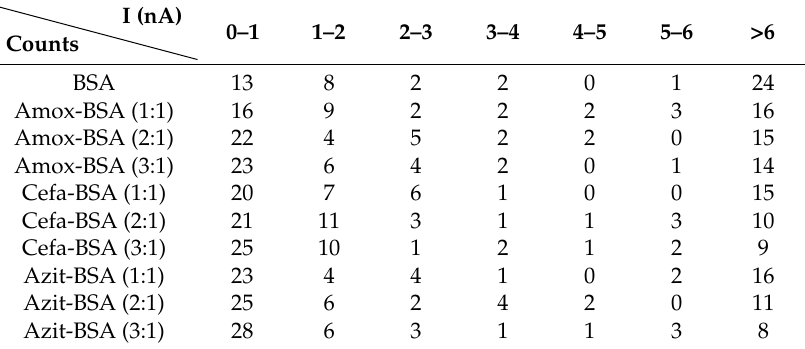
Figure 5. The I-V characteristics of BSA and Amox-BSA system ( a ), Cefa-BSA system ( c ), and Azit-BSA system ( e ). At + 2.0 V, the number of curves with currents falling within the ranges 0–1 nA and > 6 nA was determined. Shown in the figure is the I-V counts vs. current, for Amox-BSA system ( b ), Cefa-BSA system ( d ), Azit-BSA system ( f ). Table 2. The counts of I value of the selected 50 I-V curves at ± 2.0 V